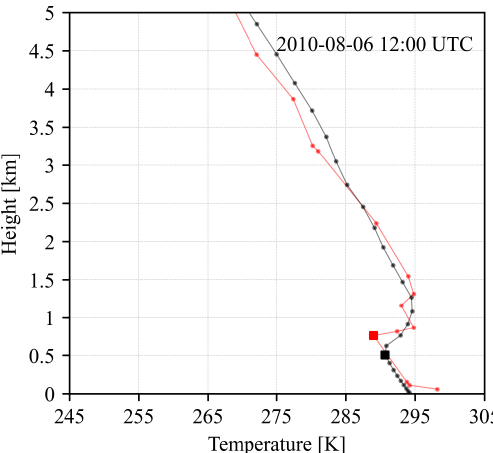
Figure C2. Typical vertical temperature profiles at Funchal from the radiosonde observations (red line) and the model simulation (black line) on 6 August 2010 at 12:00UTC. Nearest-neighbour interpola- tion is used to extract data from the model simulation at Funchal. The red and black squares represent the inversion height calculated from the vertical temperature